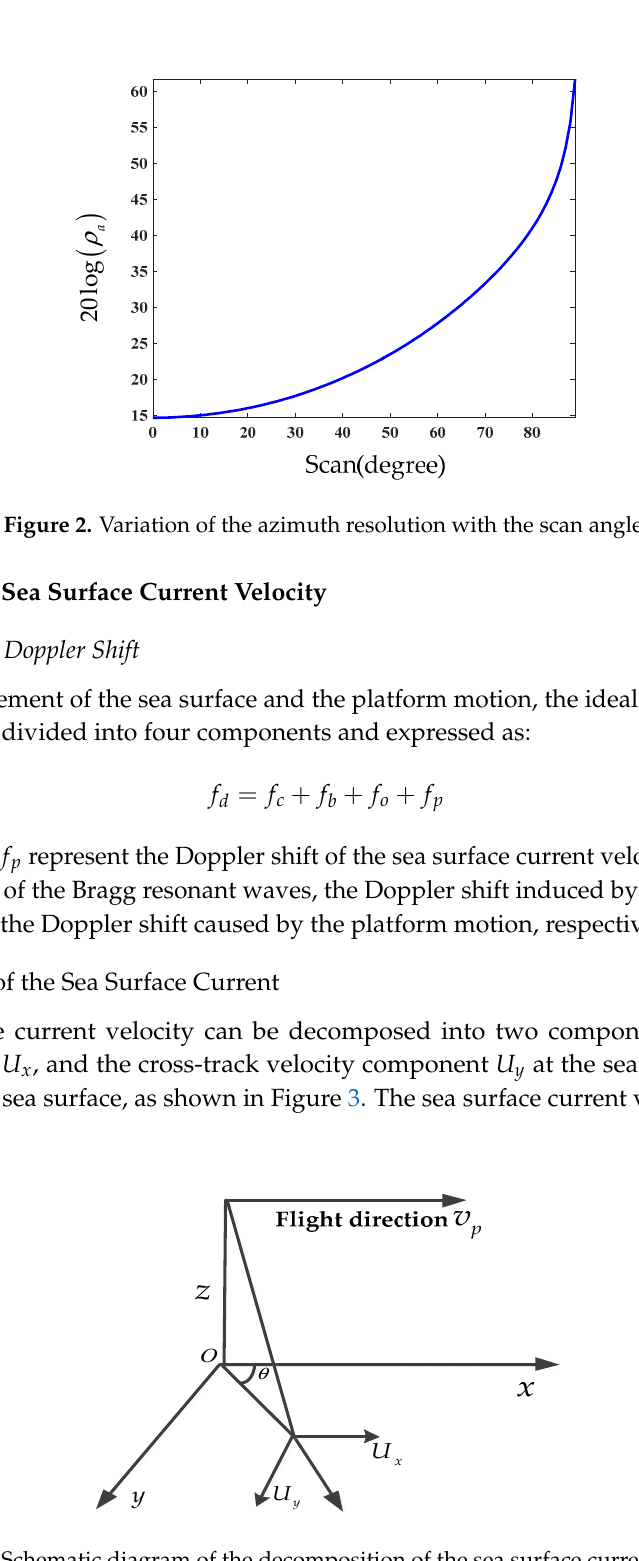
Figure 3. Schematic diagram of the decomposition of the sea surface current velocity.